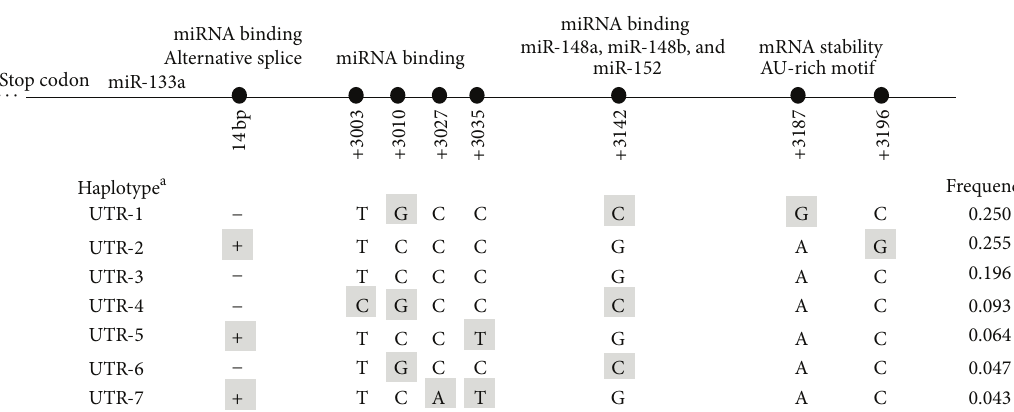
Figure 3: The most frequent haplotypes of the HLA-G 3 󸀠 untranslated region according to the 1000 Genomes data. a Haplotypes were named according to [27]. b Haplotype frequencies considering 21 worldwide populations